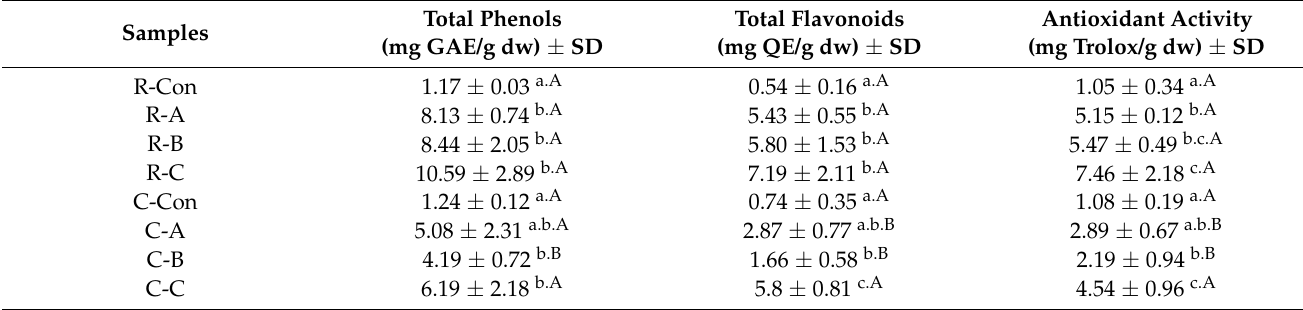
Table 1. Total phenols, total flavonoids and antioxidant activity of raw and cooked cod